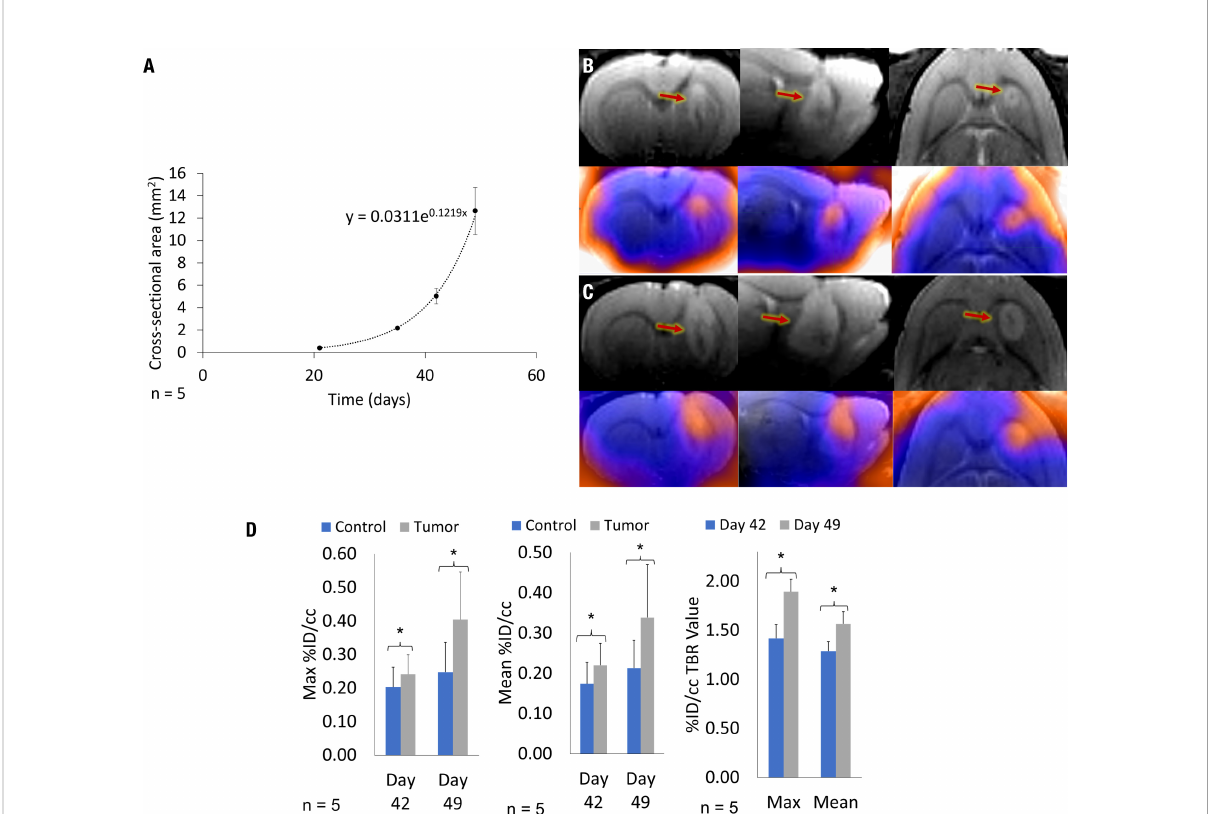
FIGURE 3 Serial MRI of a representative rat and cumulative mean GBM10 growth over time, following intracranial implantation based on serial 18 F-FET PET/MRI. There is a marked increase in tumor size and a larger area of 18 F-FET PET activity. (A) On day 49, the tumor was well delineated. The mean cumulative tumor growth over time was determined across all fi ve Rag2 -null rats, following intracranial GBM10 implantation assessed using serial MRI. (B) Triplanar coronal, sagittal, and horizontal 3D T2-weighted images (top row) and 18 F-FET PET/MRI fusion (bottom row) were acquired simultaneously on day 42, showing tumor size and 18 F-FET PET activity. (C) Triplanar coronal, sagittal, and horizontal 3D T2-weighted images (top row) and 18 F-FET PET/MRI fusion (bottom row) were acquired simultaneously on day 49, showing tumor size and 18 F-FET PET activity. (D) Quanti fi cation of serial Max and Mean %ID/cc, and Max and Mean %ID/cc TBR for serial 18 F-FET PET/CEST MRI. Graphs present 18 F- FET PET activity for both control (blue) and tumor (gray) VOI assessment, with signi fi cance at P < 0.05. There was a signi fi cant difference in 18 F- FET PET activity in the tumor, based on Mean %ID/cc TBR and Max %ID/cc TBR, between days 42 and